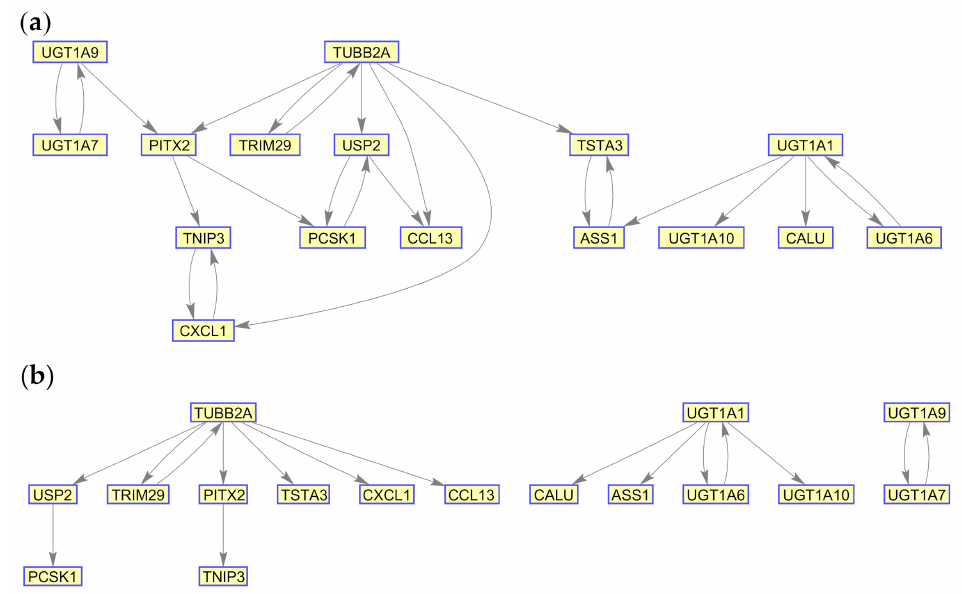
Figure 3. Gene regulatory network (GRNs) generated from the application of MIDER on the IBD Dataset. ( a ) GRN with all edges selected (no threshold). ( b ) GRN with selected edges (threshold corresponding to 65%